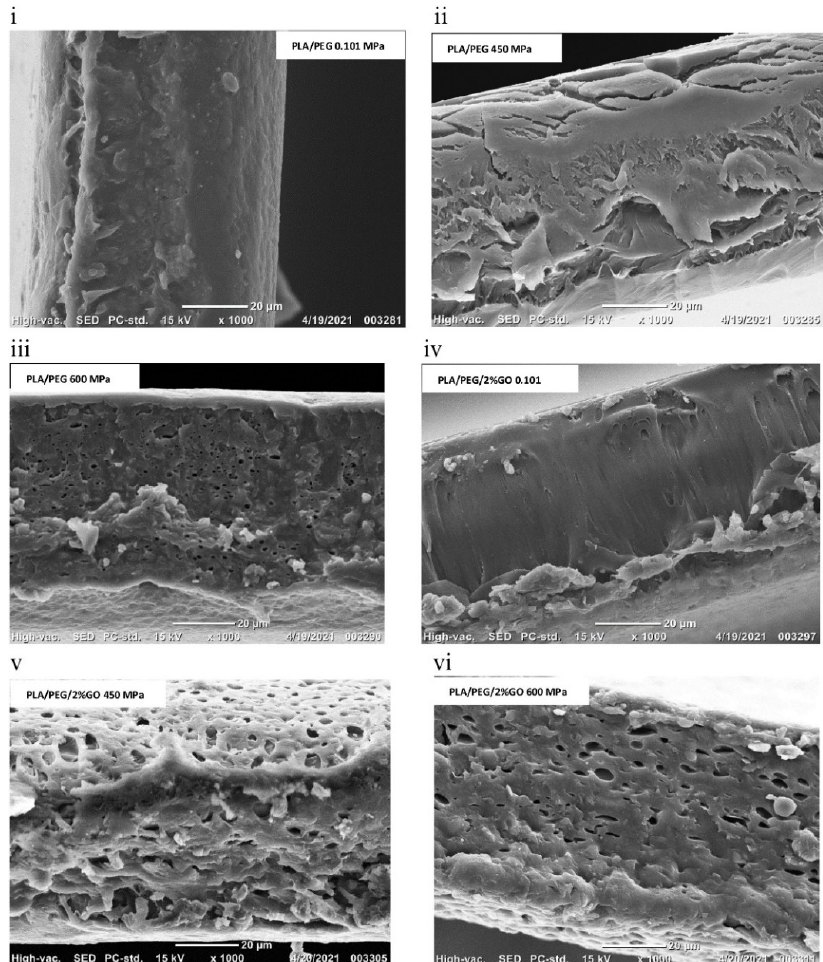
Figure 6. SEM cross sections of the PLA ‐ based films PLA/PEG and PLA/PEG/2% GO films: ( i ) PLA/PEG at 0.101 MPa; ( ii ) PLA/PEG at 450 MPa; ( iii ) PLA/PEG at 600 MPa; (iv) PLA/PEG ‐ 2% GO at 0.101 MPa; ( v ) PLA/PEG ‐ 2% GO at 450 MPa; ( vi ) PLA/PEG ‐ 2% GO at 600 MPa (×1000 magnification), Reprinted with permission from Ref. [51], Copyright (2022) Elsevier.